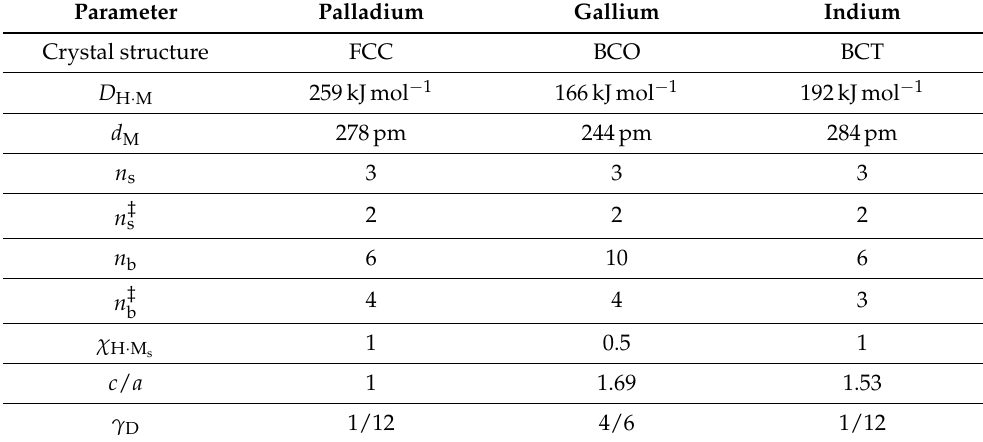
Table 2. Overview of the relevant parameters in the modeling of membranes based on palladium, gallium and indium